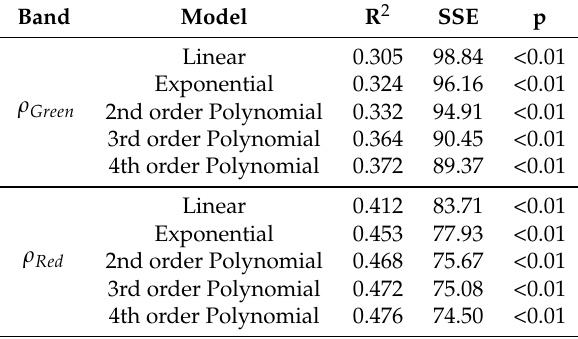
Statistical modeling results for each combination of bands/ratios selected and fitting